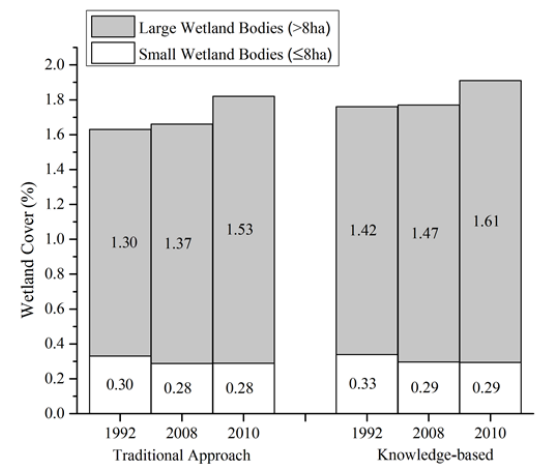
Figure 6. Comparison of cover changes of wetland size groups for three study years at the metropolitan